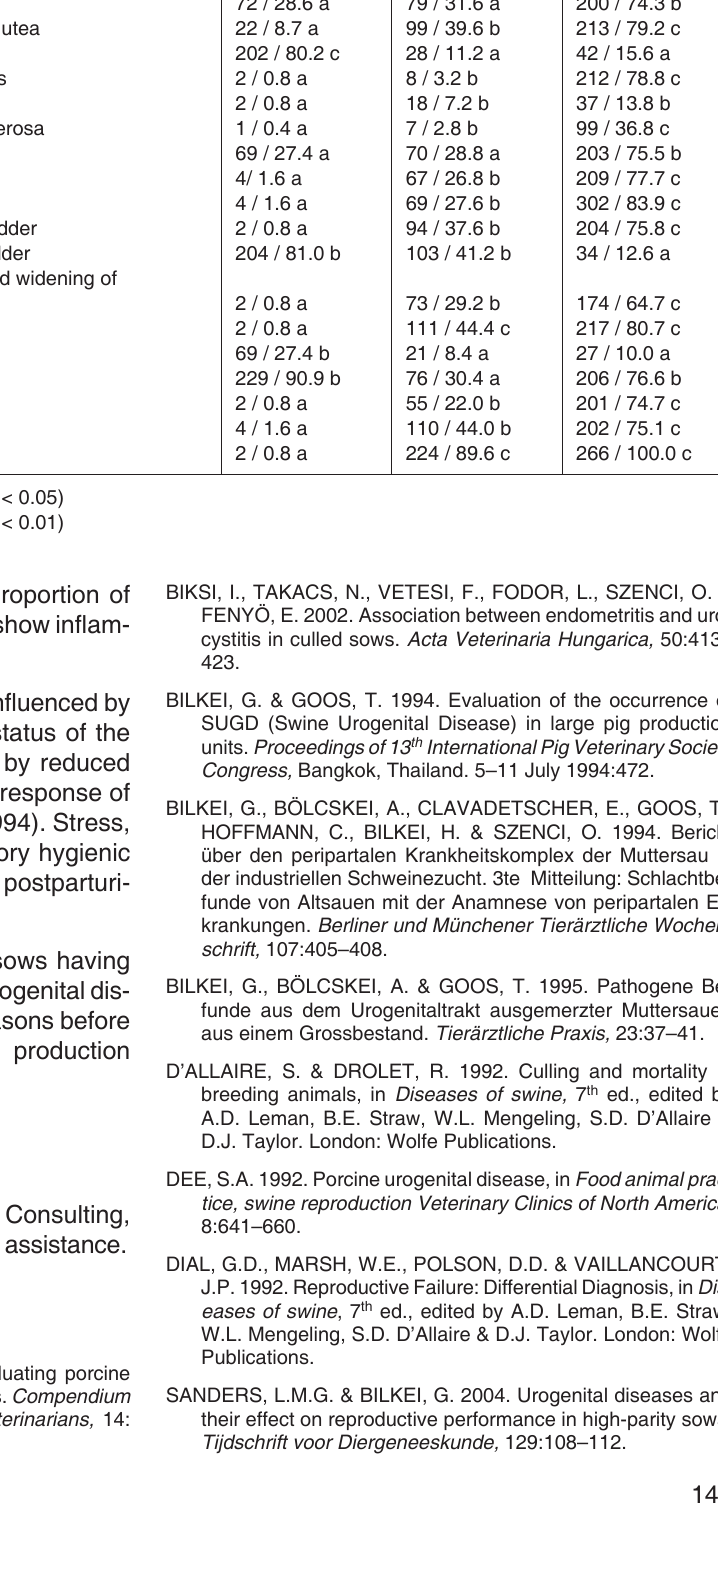
Parity 3–5 Parity > 5 ( n = 252) ( n = 250) ( n = 269) 81 / 32.1 a 72 / 28.6 a